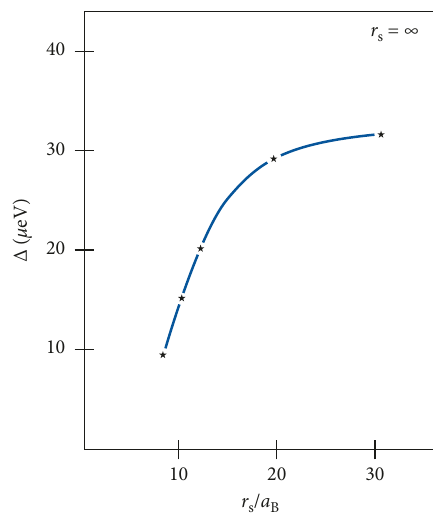
Figure 8: The numerical dependence of the 1s ⟶ 2p at half-height, caused by the quadratic Stark effect, on the